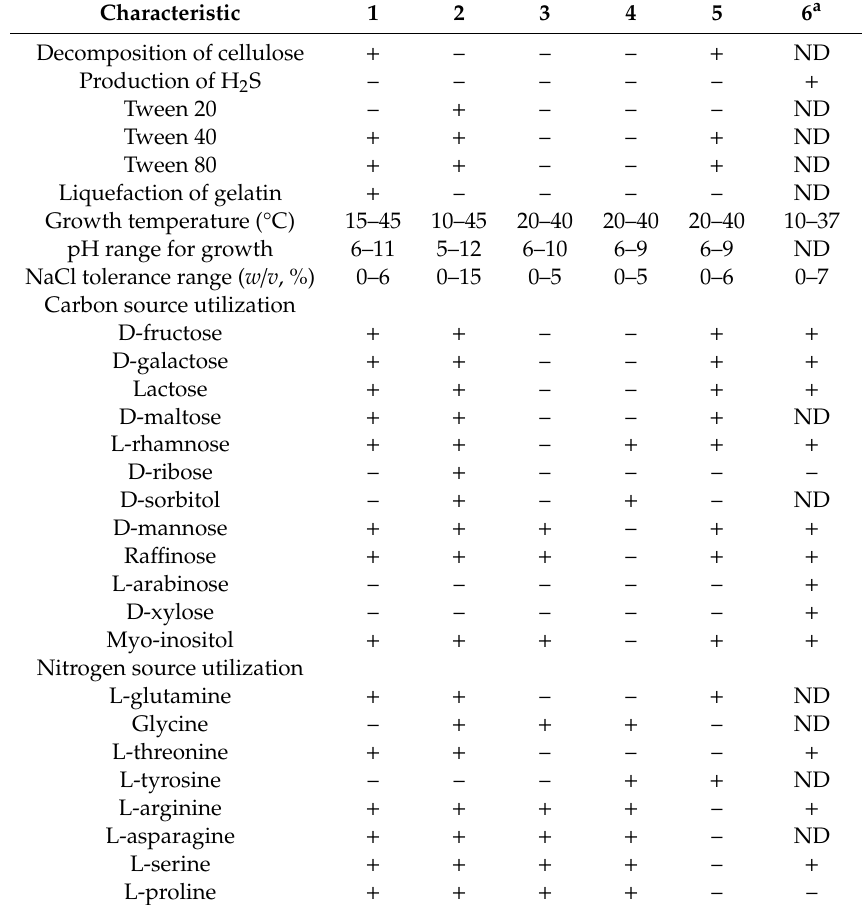
Table 2. Di ff erential characteristics of strain NEAU-SSA 1 T , S. aureoverticillatus JCM 4347 T , S.